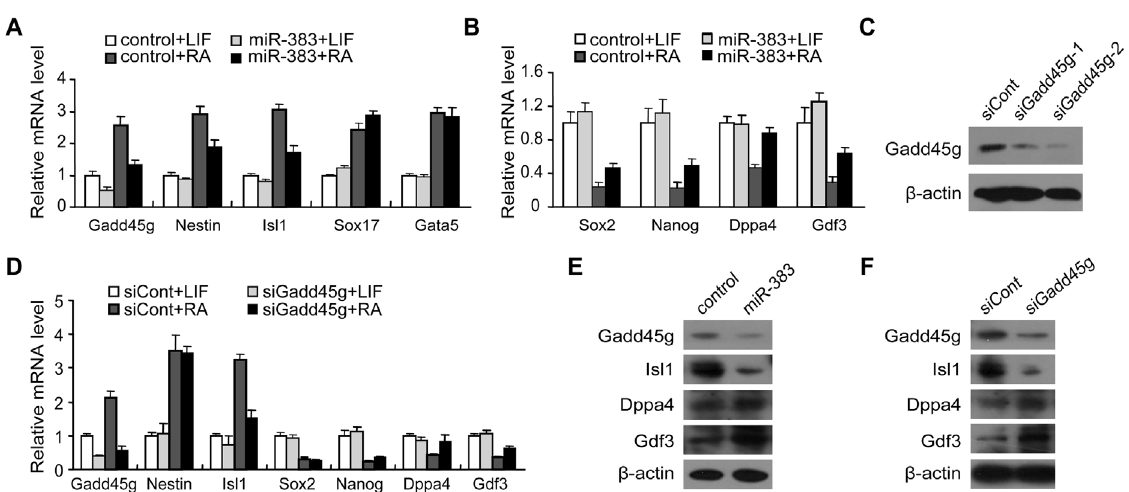
Figure 5. miR-383 modulates ES cell differentiation through Gadd45g. (A and B) Quantitative RT-PCR analysis for differentiation (A) and pluripotency (B) marker genes in miR-383 mimic or control transfected ES cells cultured with LIF or with RA for 3 days. The data are shown as relative expression compared with the control cells cultured in the presence of LIF (set as 1.0). Values are means ¡ SD. (C) Protein levels of Gadd45g were detected in R1 cells transfected with Gadd45g siRNAs. (D) Quantitative RT-PCR was performed to analyze the expression of Nestin, Nanog, Sox2, Dppa4, Gdf3, and Isl1 between control and Gadd45g siRNA transfected ES cells cultured with LIF or RA. The mRNA levels at control siRNA transfected cells were set at 1.0. Values are means ¡ SD. (E and F) The protein levels of Isl1, Dppa4 and Gdf3 were examined by western blotting after miR-383 overexpression (E)or Gadd45g siRNA (F) in the conditions of RA